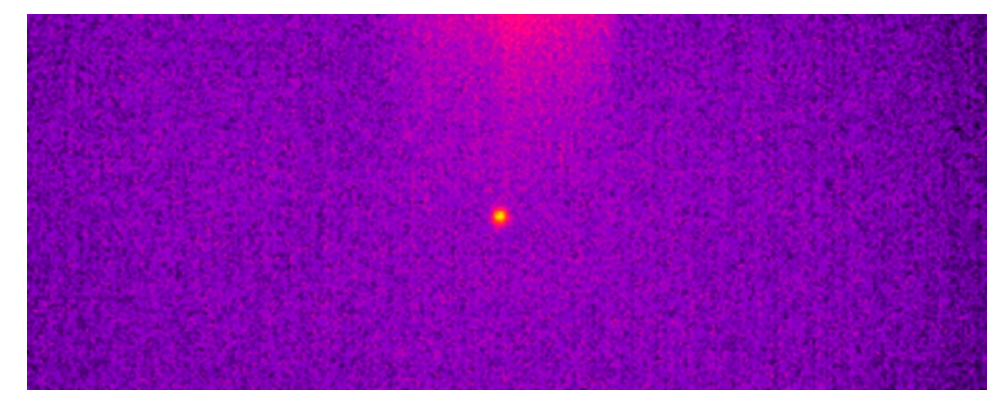
t = 0.275 s, Δ T = 0.2 ℃ (experiments) Figure 11. Cont